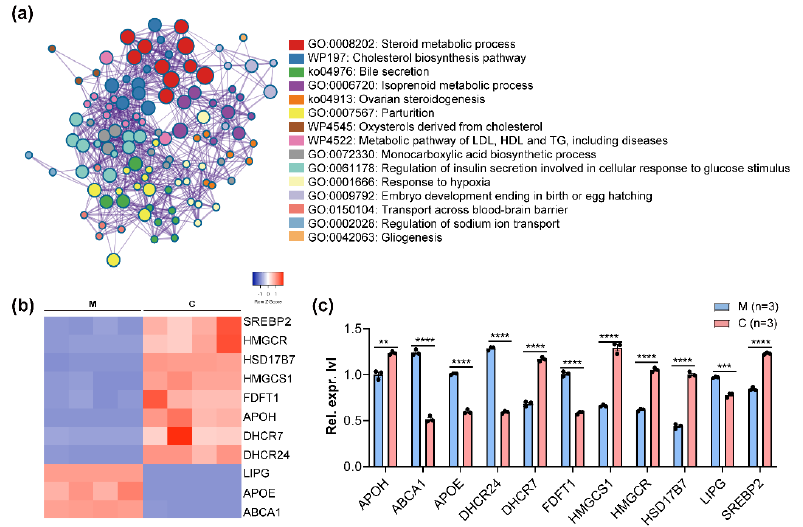
Figure 2. Cholesterol biosynthesis in CSFV-infected PK-15 cells. ( a ) GO and KEGG enrichment for differentially expressed genes in CSFV-infected PK-15 cells. ( b , c ) The expression of gene in- volved in cholesterol biosynthesis was detected in CSFV-infected PK-15 cells; ** p < 0.01; *** p <